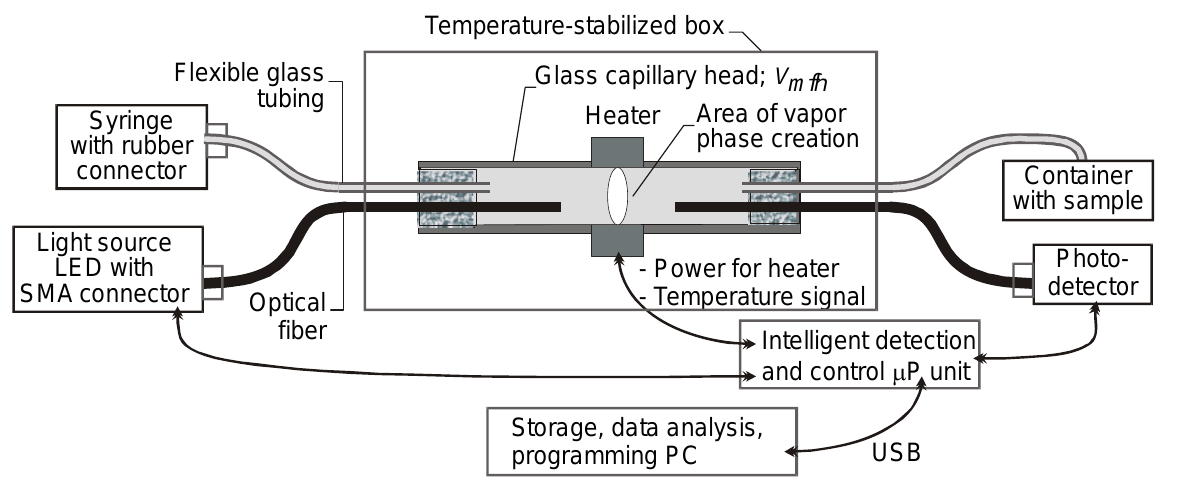
Figure 12. Fiber-optic capillary sensor of transparent liquids with local heating